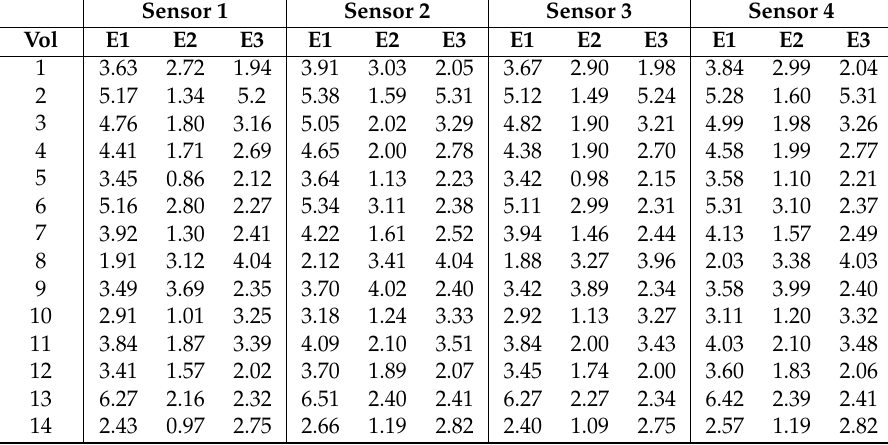
Table 5. Spatial displacement ( Disp ) measured by all sensors on each of the exercises. E1 means Exercise 1; E2 Exercise 2; and E3 Exercise 3. In all cases, displacements are expressed in